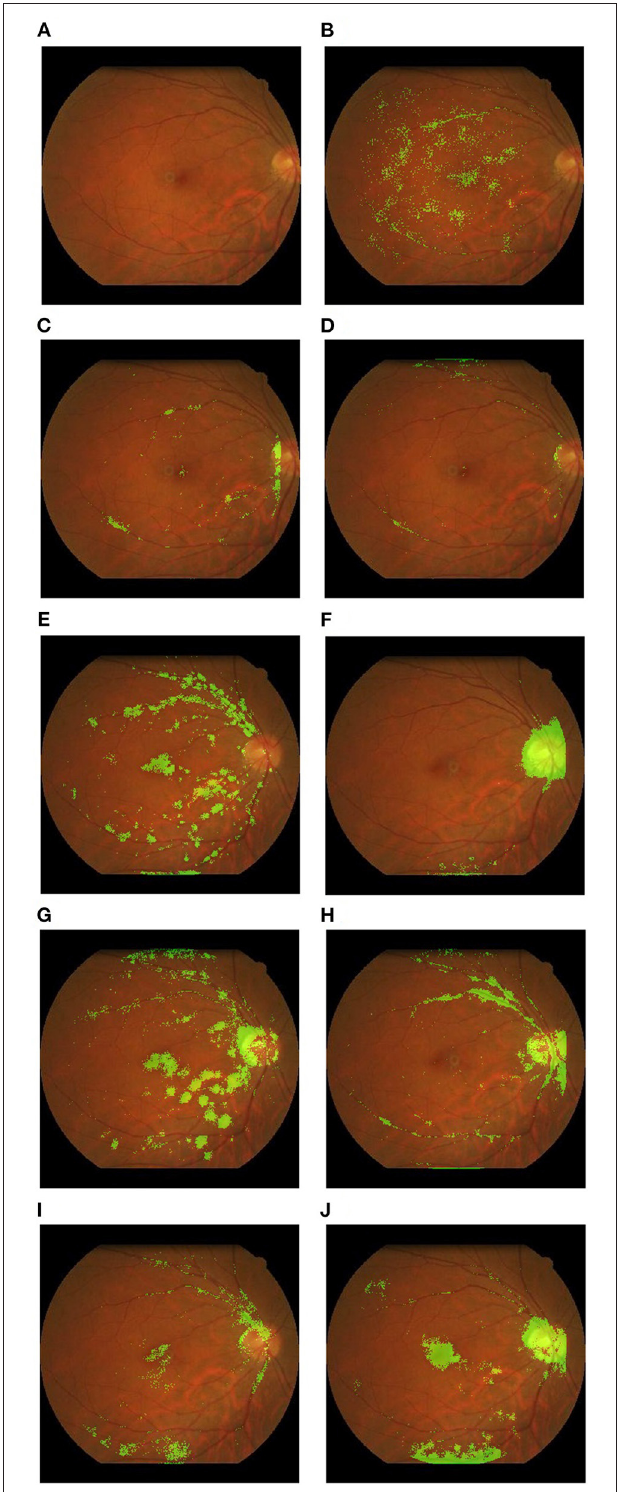
FIGURE 2 | Example heatmaps overlaid on retinal fundus photographs highlighting areas of interest. These examples were derived from the authors’ research database. (A) Original photograph with no overlay; (B) red blood cell count; (C) systolic blood pressure; (D) Weight; (E) age; (F) body mass index; (G) creatinine; (H) diastolic blood pressure; (I) hemoglobin; (J)